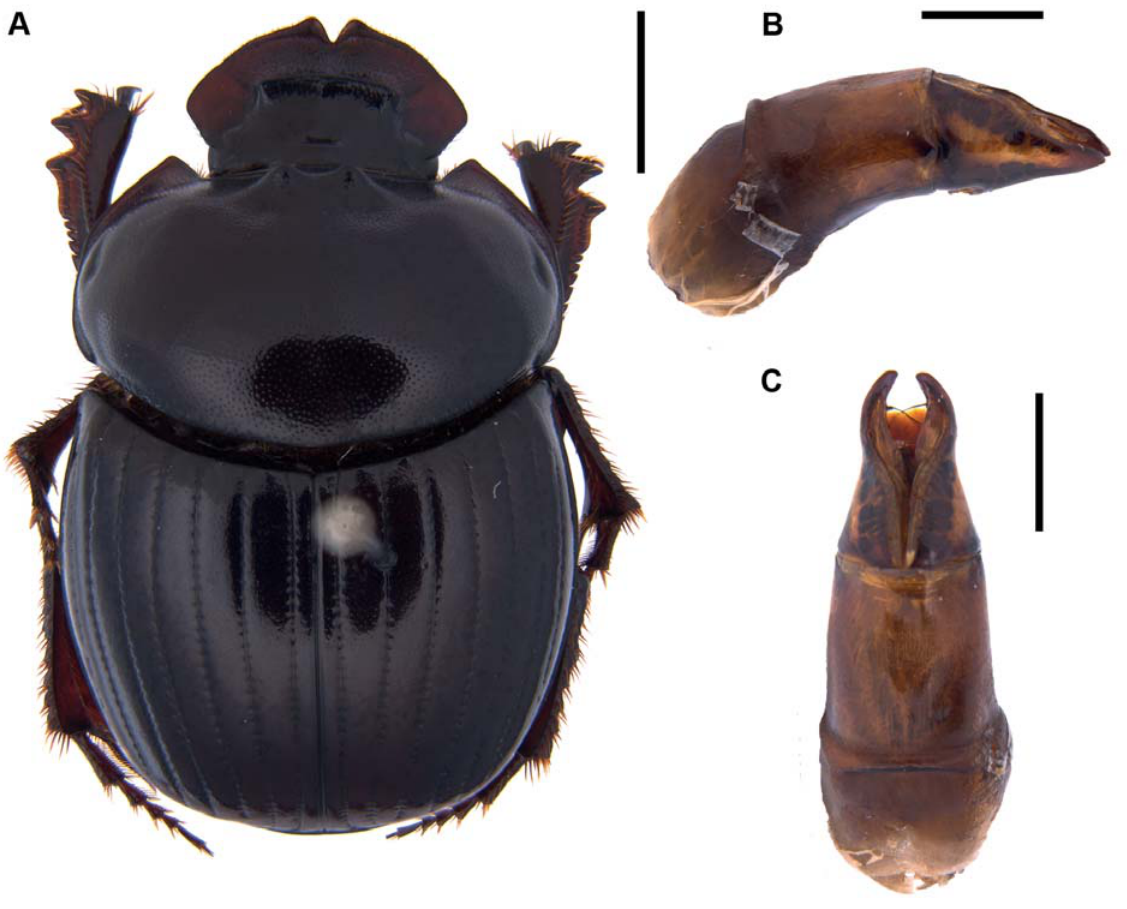
Fig. 7. Canthidium stofeli sp. nov., holotype (CEMT) A . Dorsal view. B . Lateral view of aedeagus. C . Dorsal view of aedeagus. Scale bars: 1